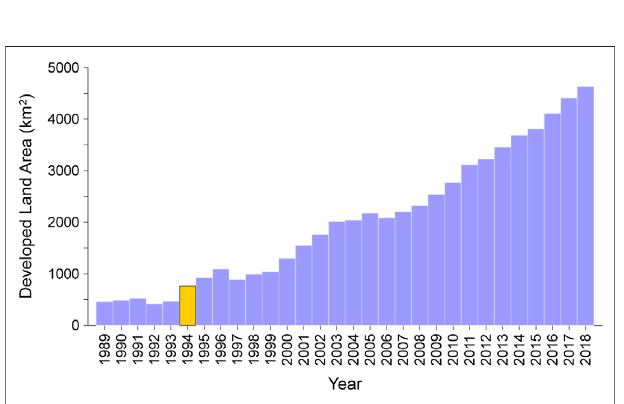
FIGURE 2 | Changes in the developed land area of the Sichuan – Chongqing area (1989 – 2018). The data are from the statistical yearbooks of Sichuan Province and Chongqing Municipality. The yellow column (1994) indicates the beginning of the fast urbanization development stage (FUDS).